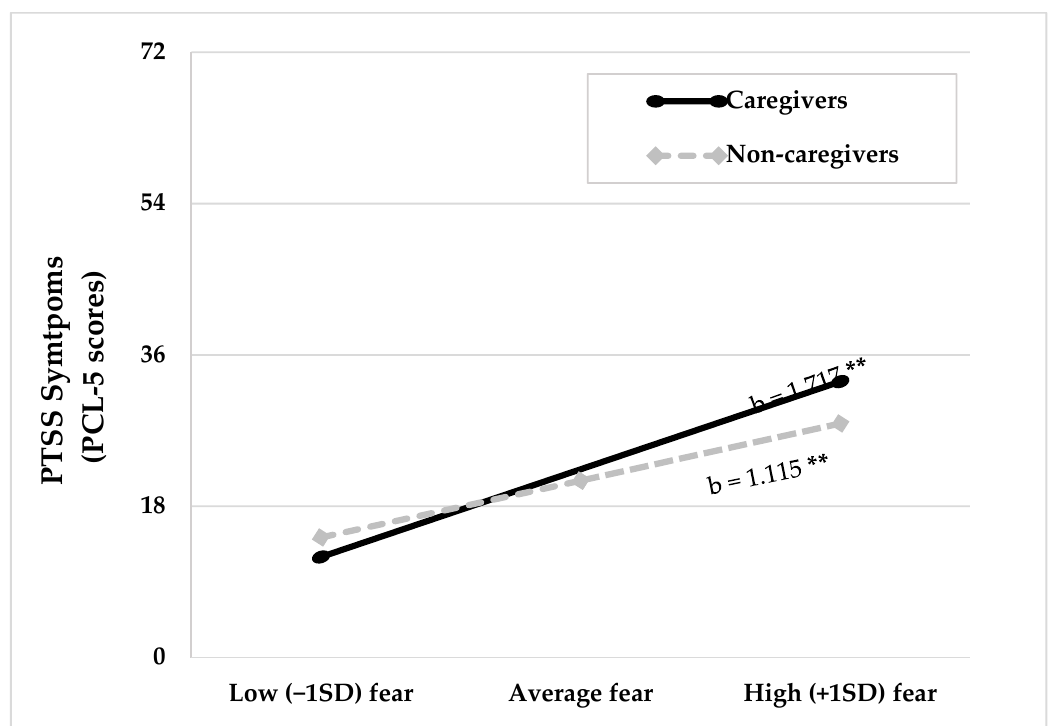
Figure 2. Plots and simple slopes for the significant moderation effect of caregiving. Caregiving moderates the relationship between fear of COVID-19 (displayed on the x -axis) and PTSS (displayed on the y -axis). Mean of fear of COVID-19 was 18.73 with a standard deviation of 6.08. Simple slope analyses were conducted at three levels of fear: low (one standard deviation below the mean), average (mean value of fear of COVID-19) and high (one standard deviation above the mean). Notes : b = unstandardized coefficients, ** p < 0.01.